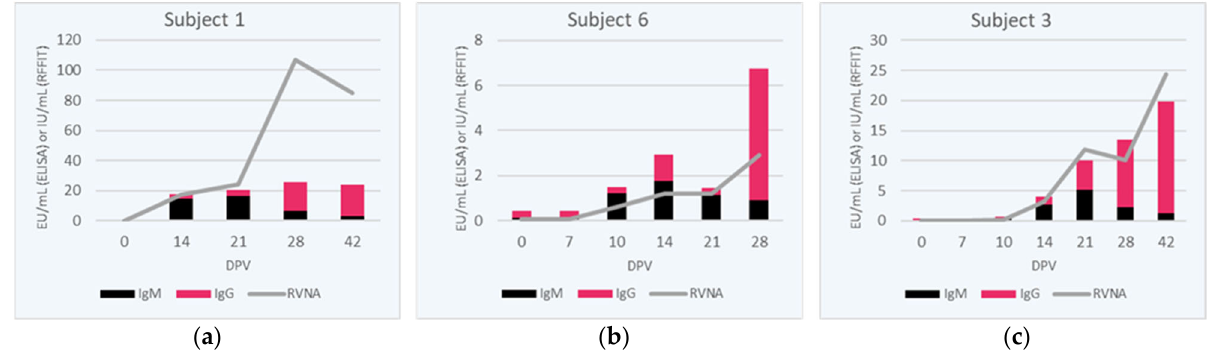
Figure 4. Individual variation in rabies antibody kinetics post-PrEP demonstrated in three subjects, 1 in panel ( a ), 6 in panel ( b ), and 3 in panel ( c ). The IgM ELISA result is in black, the IgG ELISA result is in magenta in the stacked bar, and the RVNA (RFFIT) result is the gray line. Table 1. IgM/IgG EU/mL ratio (percent) per vaccine recipient per day post vaccination (DPV).